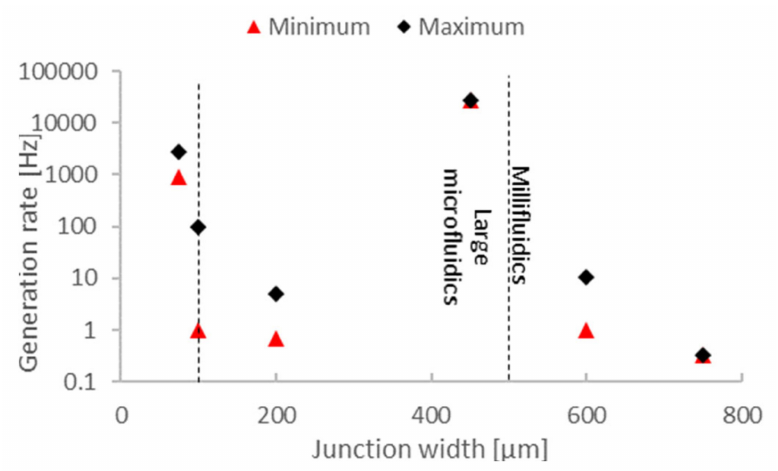
Figure 5. The generation rate of 3DP droplet microfluidic chips varies from 1 Hz up to 10 kHz in range. Comparing the junction width and the reported droplet generation rates, we can see that 3DP droplet generators are capable of reliably generating droplets at rates <100 Hz. Some demonstrated applications exist that have exceeded a 1 kHz generation rate, but the majority of 3DP droplet microfluidics with junctions between 100 and 500 µ m in width could generate droplets at up to a 100 Hz generation rate. However, due to the scarcity of data, the relationship between the channel geometry and generation rate should be analyzed further.